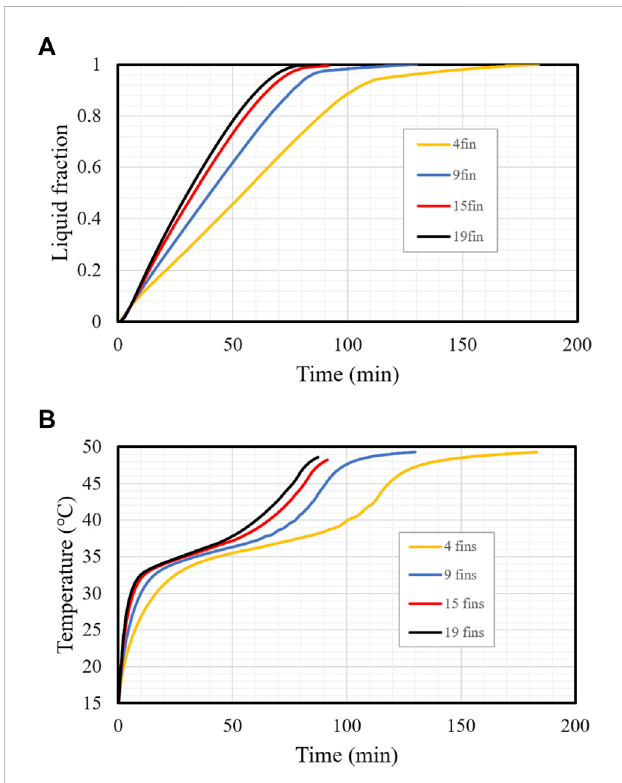
FIGURE 11 (A,B) Liquid fraction (A) and mean temperature (B) with different fi n